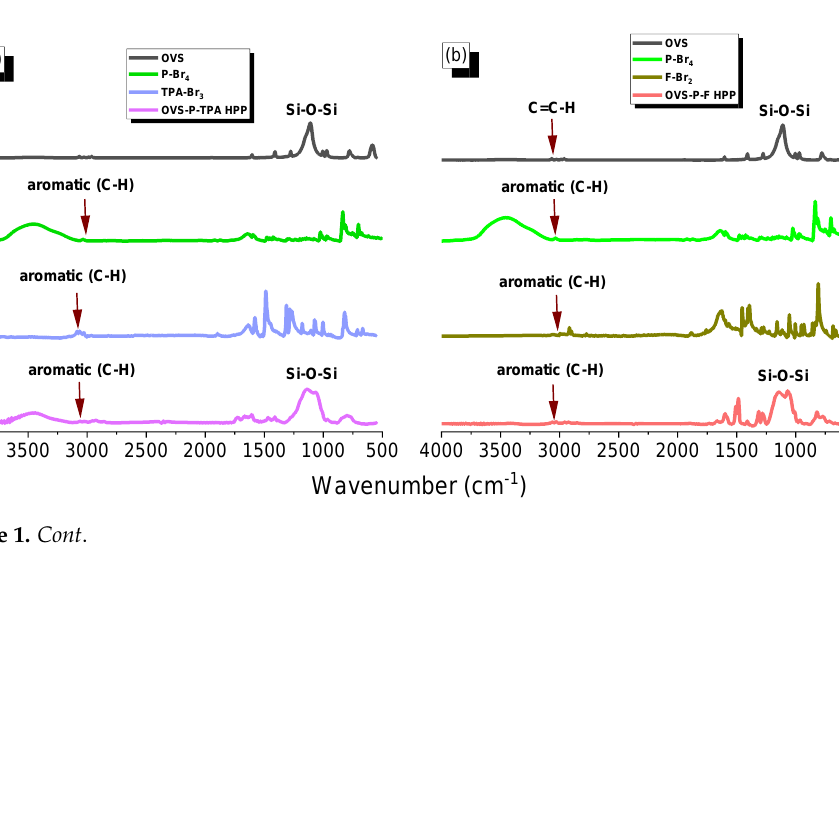
Figure 1. FTIR analyses of ( a ) OVS, P-Br 4 , TPA-Br 3 , and OVS-P-TPA HPP; ( b ) OVS, P-Br 4 , F-Br 2 , and OVS-P-F HPP; ( c ) the 13 C NMR solid-state profile; and ( d ) the 29 Si NMR solid-state profile of OVS- P-TPA HPP and OVS-P-F HPP. * denotes the side band of solid-state nuclear magnetic resonance spectroscopy (NMR). The surface chemical composition of OVS-P-TPA HPP and OVS-P-F HPP were de- tected in X-ray photoelectron spectroscopic (XPS) measurements. As can be seen in Figure 2, the Si2p (103.13 eV), Si2s (153.31 eV), C1s (285.80 eV), and N1s (401.12 eV) peaks ap- peared in the OVS-P-TPA HPP precursor (Figure 2a), whereas the Si2p (103.48 eV), Si2s (153.84 eV), and C1s (285.34 eV) signals appeared in the OVS-P-F HPP framework (Figure 2b) [68]. All the analyses above, including FTIR, XPS, 13 C, and 29 Si NMR solid-state anal- yses, strongly demonstrated the successful synthesis of OVS-P-TPA HPP and OVS-P-F HPP.